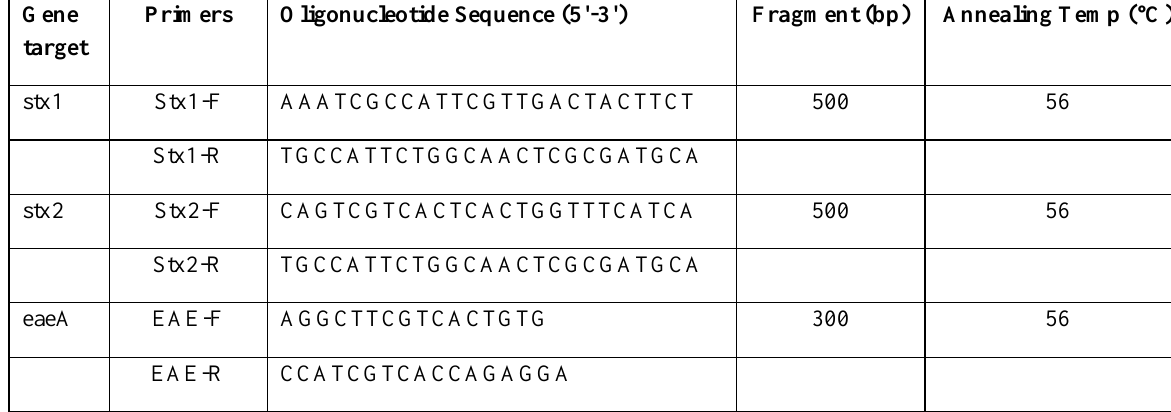
Table 1. Characterization of primers for identification of E. coli O157 (STEC) and virulence genes [17]. Both